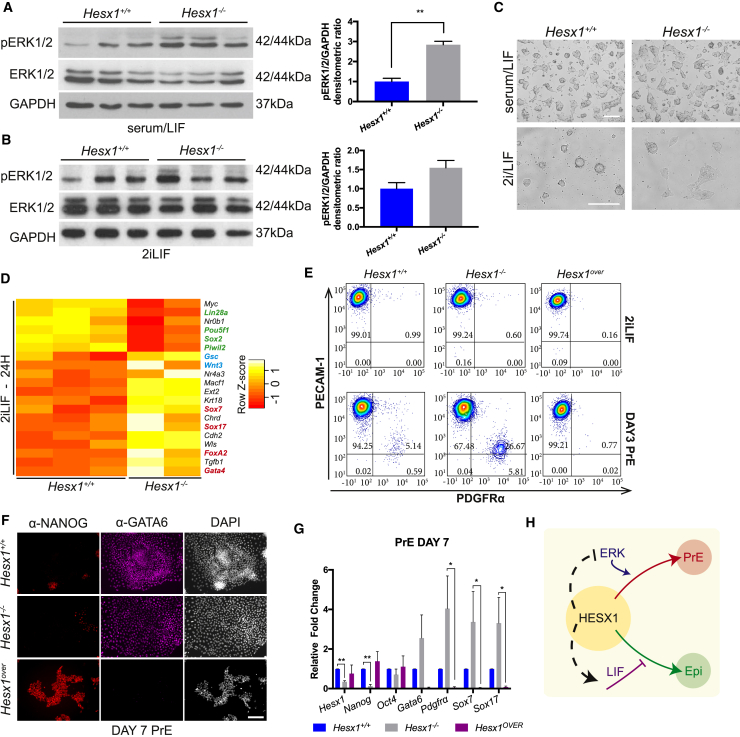
Loss of Hesx1 in ESCs Results in Increased ERK Signaling and Promotion of the PrE Fate(A and B) Western blot for pERK1/2 and ERK1/2 on WT and Hesx1−/− ESCs cultured in serum/LIF (A) and 2iLIF (B) conditions (n = 3 ESC clones in three independent experiments).(C) Bright-field images of Hesx1+/+ and Hesx1−/− ESCs cultured in serum/LIF or 2iLIF. Scale bars, 200 μm.(D) Heatmap of the differentially expressed genes showing the lower expression of pluripotency-associated (green) and higher expression of differentiation (blue and red) markers in Hesx1−/− relative to WT ESCs. Data represent the differentially expressed genes 24 h after 2i removal.(E) Flow-cytometry density plots of Hesx1+/+, Hesx1−/−, and Hesx1over ESCs cultured in 2iLIF or after 3 days of PrE differentiation. Cells are stained with PECAM-1 (y axis) and PDGFRα (x axis).(F) Immunofluorescence staining for NANOG (red) and GATA6 (purple) on Hesx1+/+, Hesx1−/−, and Hesx1over cells following 7 days of PrE differentiation. DNA is counterstained with DAPI. Scale bar, 100 μm.(G) qRT-PCR after 7 days of PrE differentiation (n = 3 ESC clones in three independent experiments).(H) Schematic depicting the summary of the findings. HESX1 promotes the undifferentiated state in ESCs by negatively regulating ERK activation and by reinforcing LIF/STAT3 signaling. Loss of Hesx1 results in increased ERK and concomitant decreased in pSTAT3 signaling with a consequent premature differentiation toward endoderm and epiblast lineages, respectively.